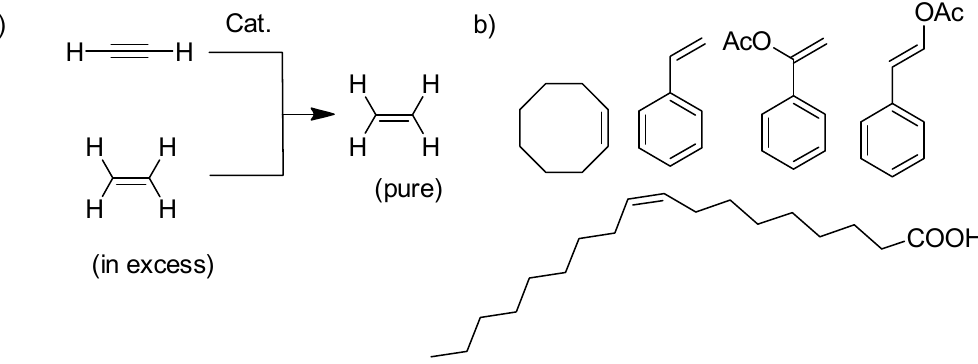
Figure 10. ( a ) Selective hydrogenation of acetylene in the presence of excess of ethylene in the presence of graphene as carbocatalysts; ( b ) chemical structures of alkenes employed for the liquid phase hydrogenation using graphene obtained from alginate.